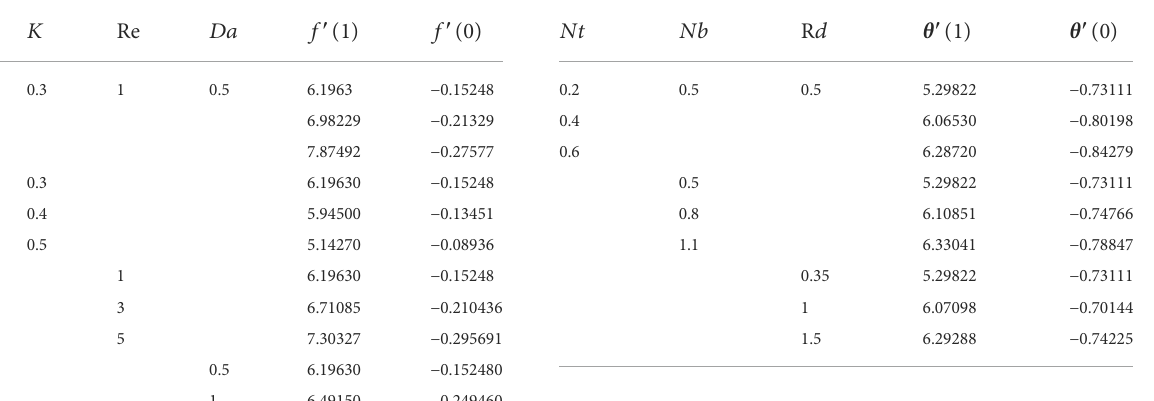
TABLE 2 Skin friction C f variations for different values of Re andDa. TABLE 3 Nusselt number Nu for variations Nb and